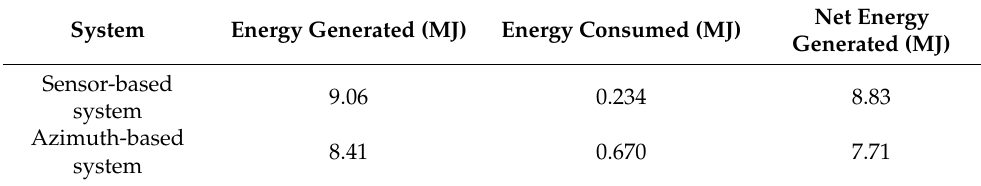
Table 3. Energy generated, consumed, and net by the azimuth- and sensor-based